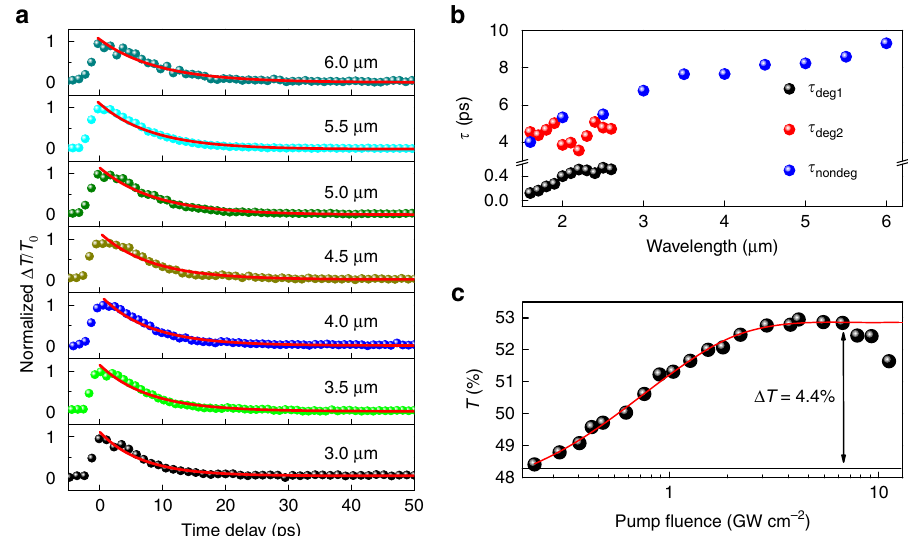
Figure 2 | Ultrafast nonlinear optical properties of Cd 3 As 2 films with 400nm thickness. ( a ) The non-degenerate ultrafast pump-probe results with the probe wavelength varying from 3 to 6 m m, and red solid lines correspond to a mono-exponential fit for t nondeg . ( b ) Fitted relaxation time constants t versus probing wavelengths for both the degenerate (black and red points) and non-degenerate (blue points) measurements. ( c ) The nonlinear absorption at a wavelength of 3 m m (black points) and fitting with a simple saturation model (red line), T ( I ) ¼ 1 (cid:2) D T (cid:3) exp( (cid:2) I / I sat ) (cid:2) T ns , where I , D T , I sat and T ns are the input intensity, modulation depth, saturation intensity and non-saturable absorbance, respectively. A modulation depth of 4.4% and a saturation intensity of B 0.78GWcm (cid:2) 2 are obtained. The horizontal black line is the base